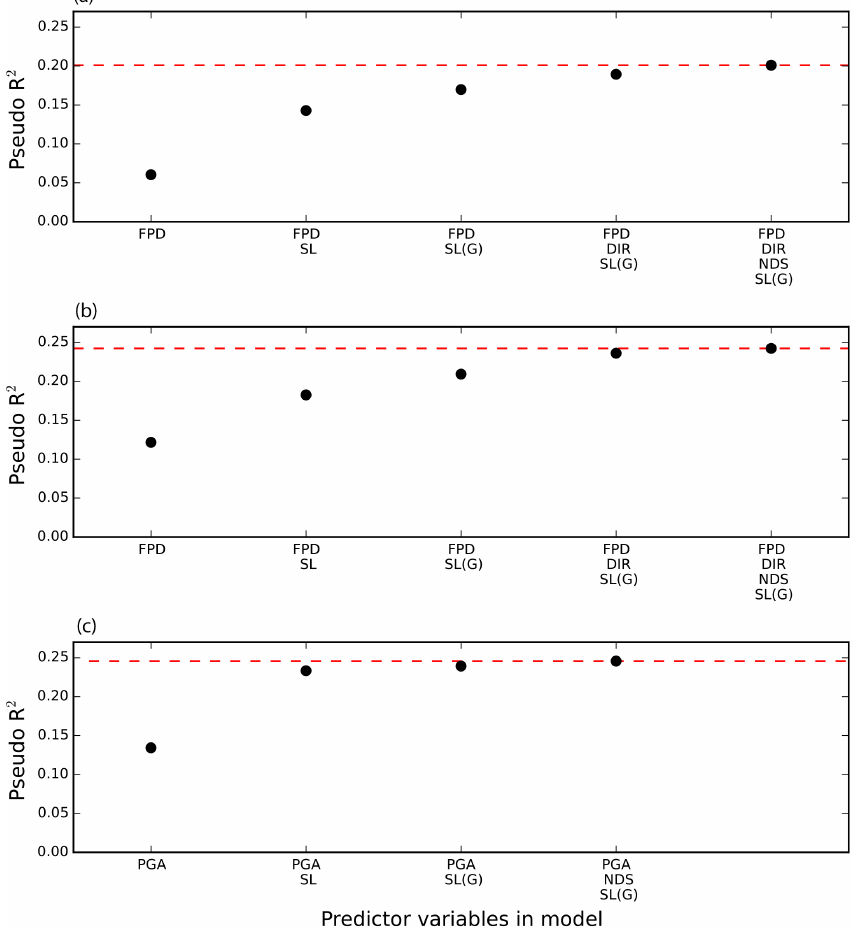
Figure 12. Relative contributions of predictor variables to the fit of the 1929 and 1968 hillslope failure probability models. Sequence of model input predictors and resulting pseudo- R 2 goodness of fit values, produced by sequentially removing the least contributing predictor variable. (a) Results from Eq. (5) for the 1929 earthquake, (b) results from Eq. (5) for the 1968 earthquake, and (c) results from Eq. (6) for the 1968